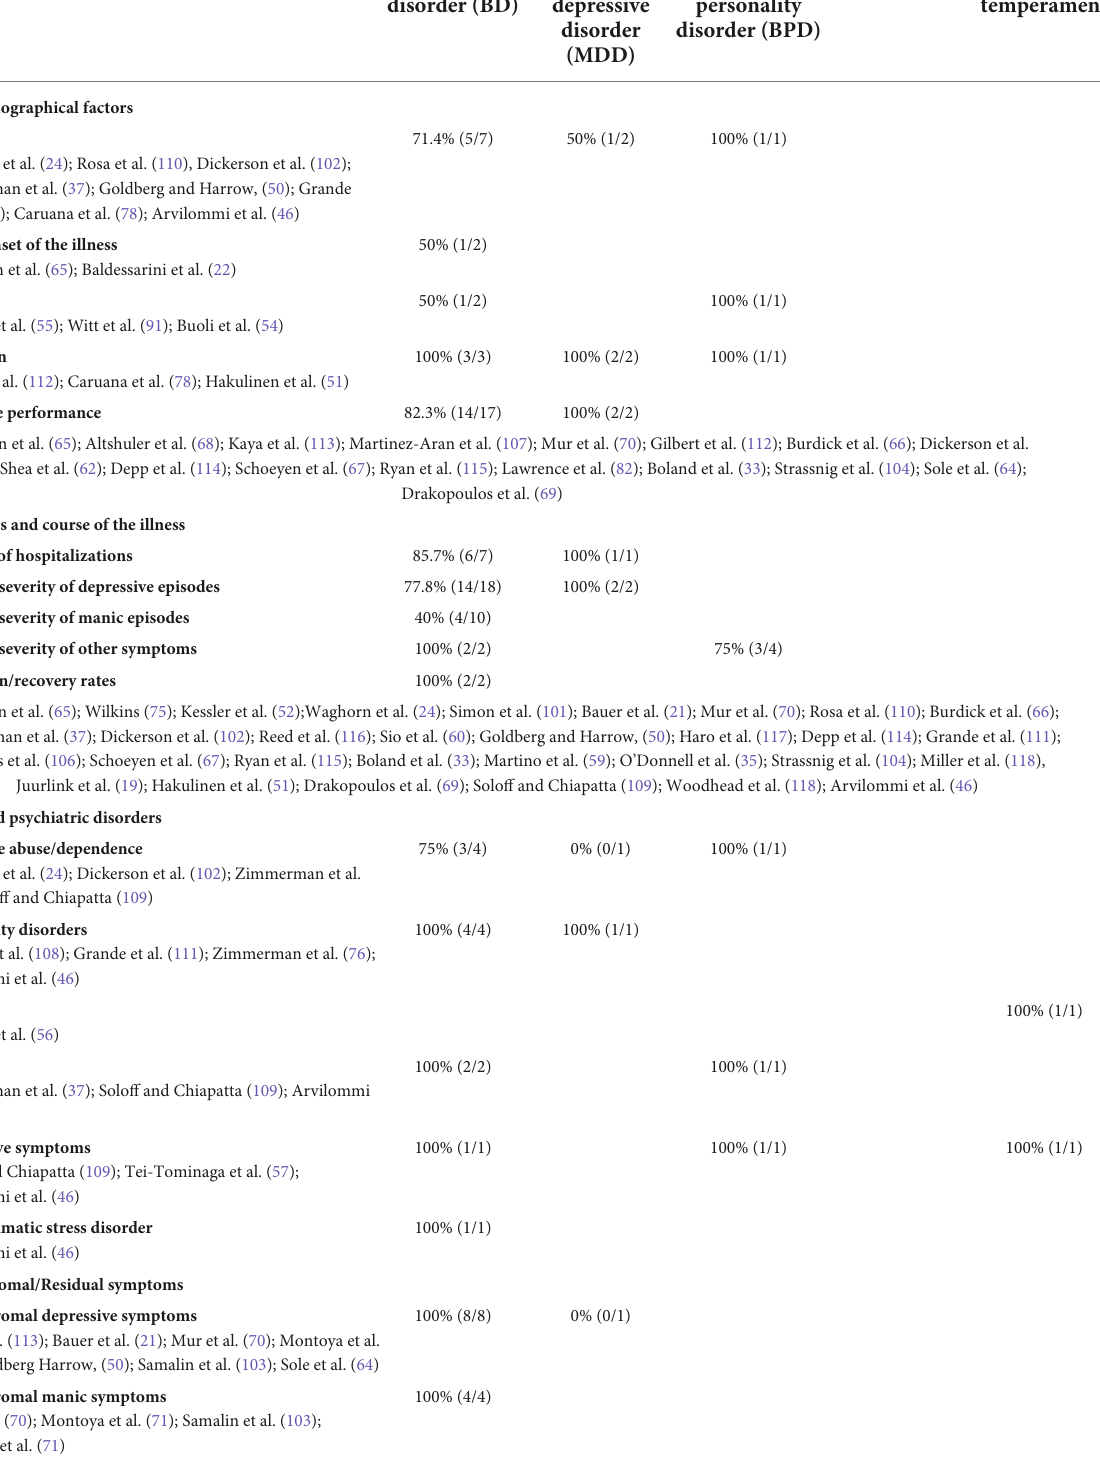
Studies reporting on given variable % (n/N)–percent, (n-number of studies where variable was significant/N-number of all studies evaluating given